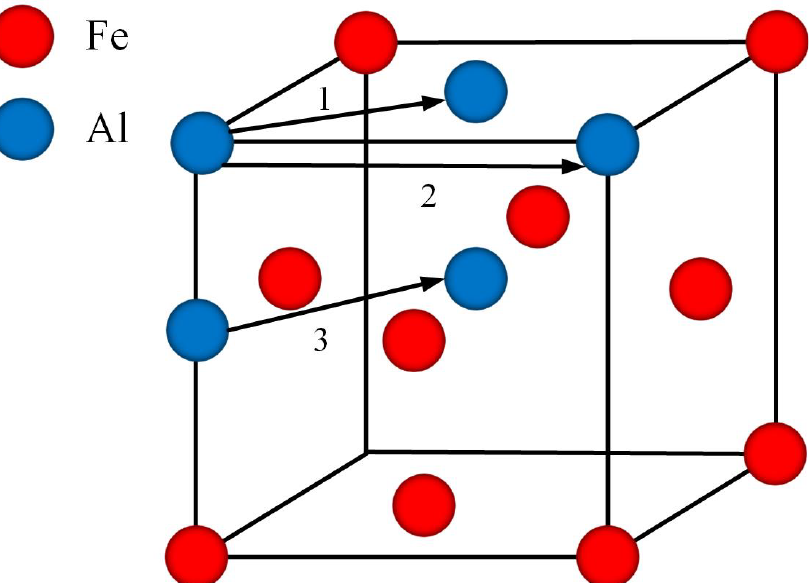
Figure 9. Three mechanisms of diffusion of Al atoms in Fe, (1. Nearest Neighbour Jumping Mecha- nism, 2. second nearest neighbour jumping mechanism, 3. gap jumping mechanism).